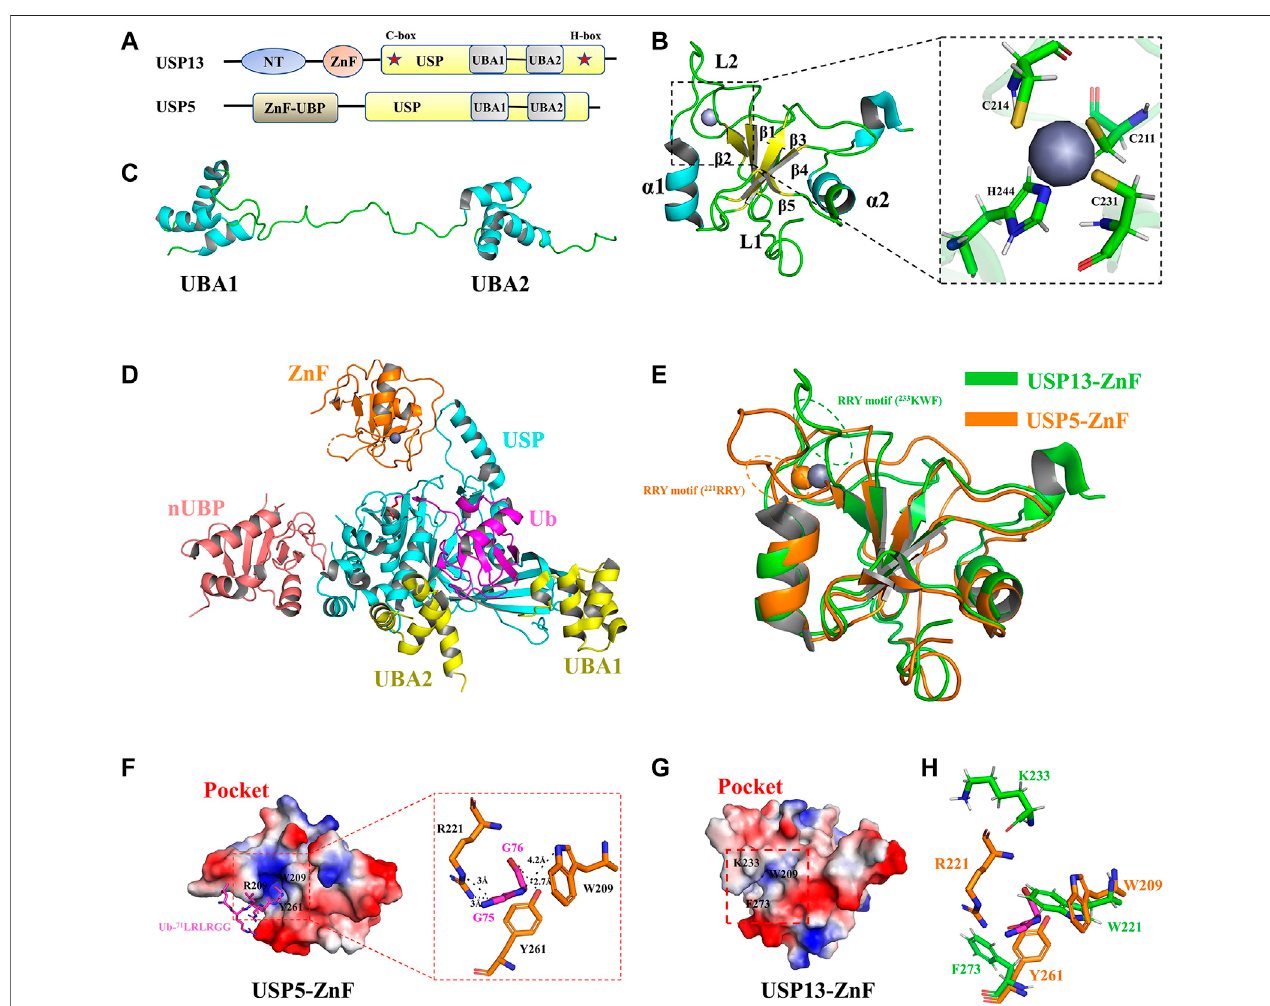
FIGURE2| StructureofUSP13andcomparisonwithUSP5-ZnF. (A) DomainstructureofUSP13andUSP5. (B) StructureofUSP13-ZnF(PDB2L80),inwhichthe α helix is blue, the β sheet is yellow, the loop is green, and the zinc ion is gray. The close-up view shows that the zinc nucleus coordinates with the peptide chain in C3H mode. (C) Structure of USP13-UBA (PDB 2LBC), in which the α helix is blue and the loop is green. (D) Structure of ubiquitin-USP5 complex (3IHP). nUBP is pink, ZnF is orange, the USP catalytic domain is blue and UBA12 is yellow. Ubiquitin is purple. (E) Comparison of the structure between USP13-ZnF and USP5-ZnF (PDB 2G43),USP13-ZnFand USP5-ZnFaregreen andorange, respectively. (F) ElectrostaticsurfaceoftheUbiquitin-USP5-ZnFcomplex(PDB 2G45).Ubiquitinglycinemotif ( 71 LRLRGG, purple) is inserted into the ubiquitin binding pocket of USP5-ZNF, and it can be seen from the close-up view that ubiquitin G75 and G76 form hydrogen bonds interact with W209, R221, and Y261 on ZnF. (H) Electrostatic surface of the USP13-ZnF. (G) The residues of the combined Ub-G75 and Ub-G76 on USP5 (orange) are displayed in sticks, and the corresponding residues in USP13 (green) are displayed in sticks.